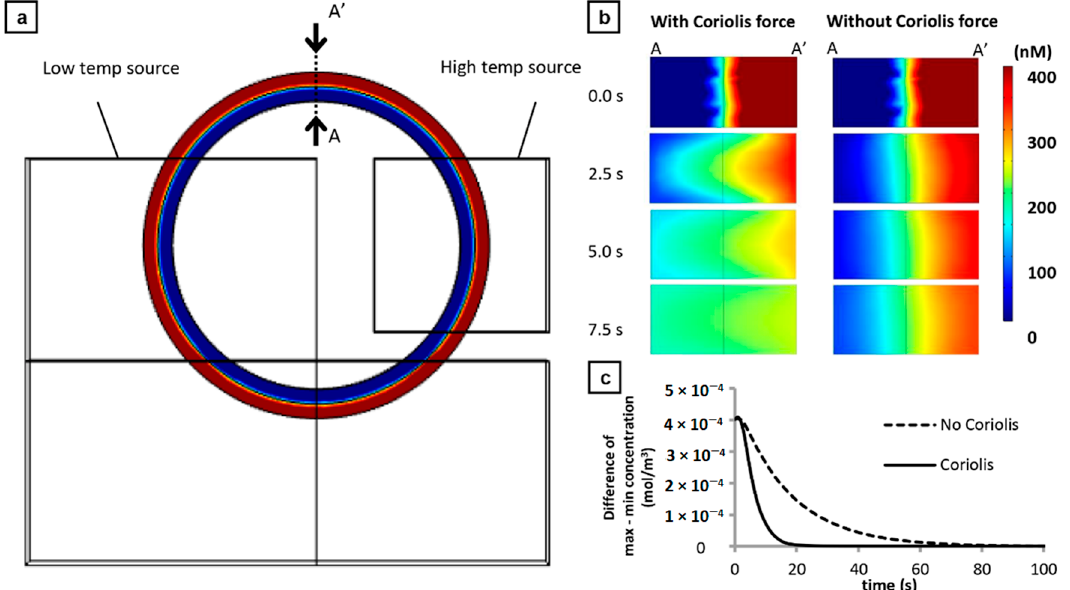
Figure 3. Simulation of concentration gradients in the ring-structured channel for a hypothetical case. ( a ) Model used where two solutions at different concentrations (Red — 400 nM and Blue — 0 were placed as concentric hollow cylinders. The concentration gradients were analyzed at region A–A’. ( b ) Time-course gradient distribution for centrifugal-assisted thermal convection (left) and free convection (right). ( c ) Graph showing the full time required for a complete mixing in the two cases studied; 4 times faster in the case with Coriolis force compared to without.